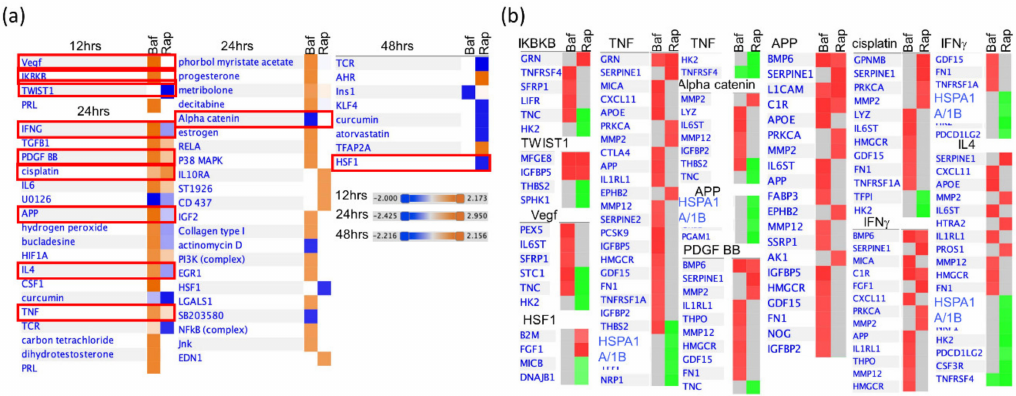
Figure7. IPA-determinedupstreammoleculesalteredby2nMBafA1or200nMrapamycin. ( a )Predicted a ff ected upstream molecules with Z-Score > 1.96 (orange) or < − 1.96 (blue) at each time point. ( b ) Some of the upstream molecules (outlined in red in a ) are shown in greater detail, with dysregulation of specific proteins indicated (red indicates up-regulated; green indicates